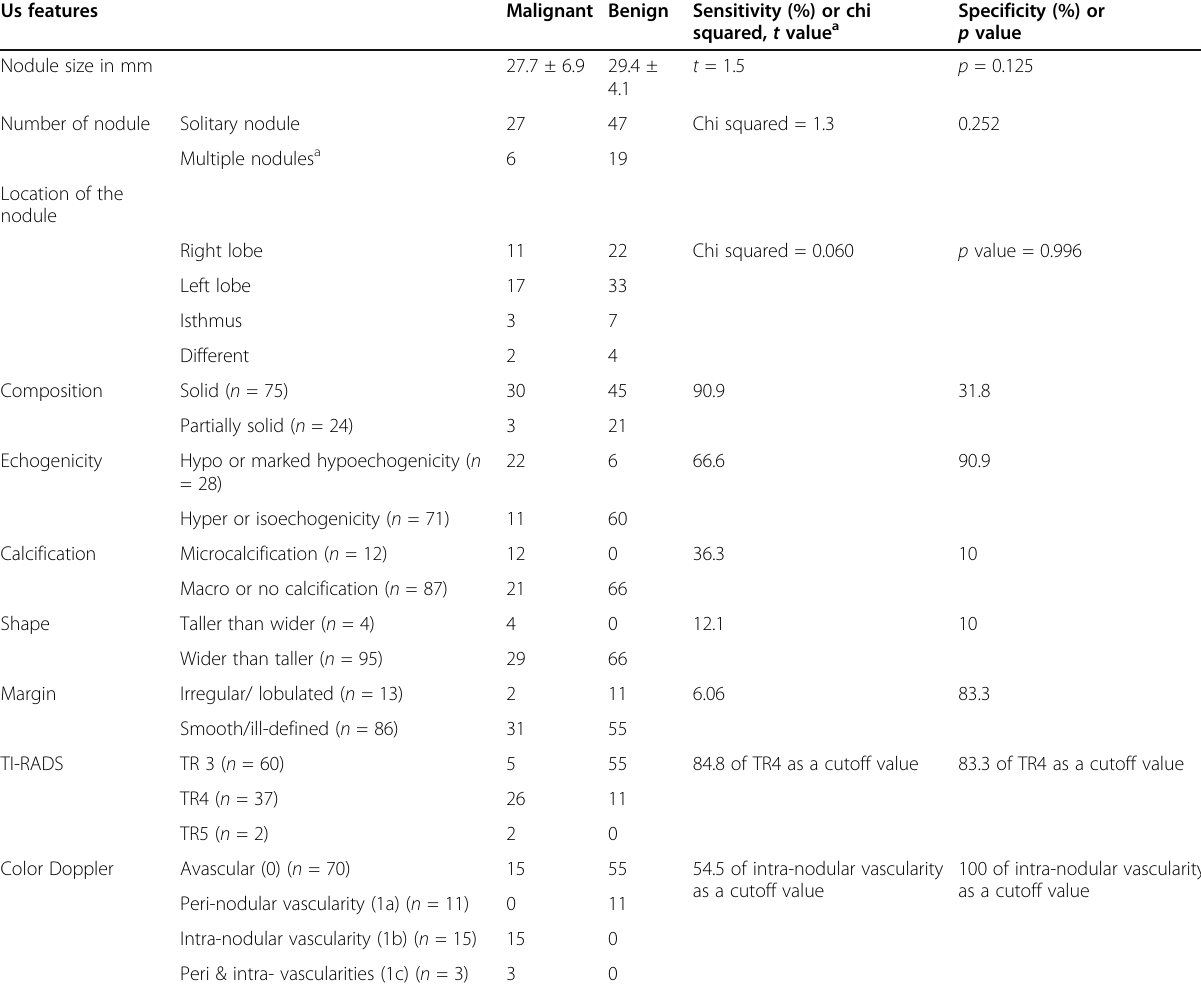
Table 1 Showing the diagnostic performance of conventional B-mode and color Doppler characteristics of the nodules Us